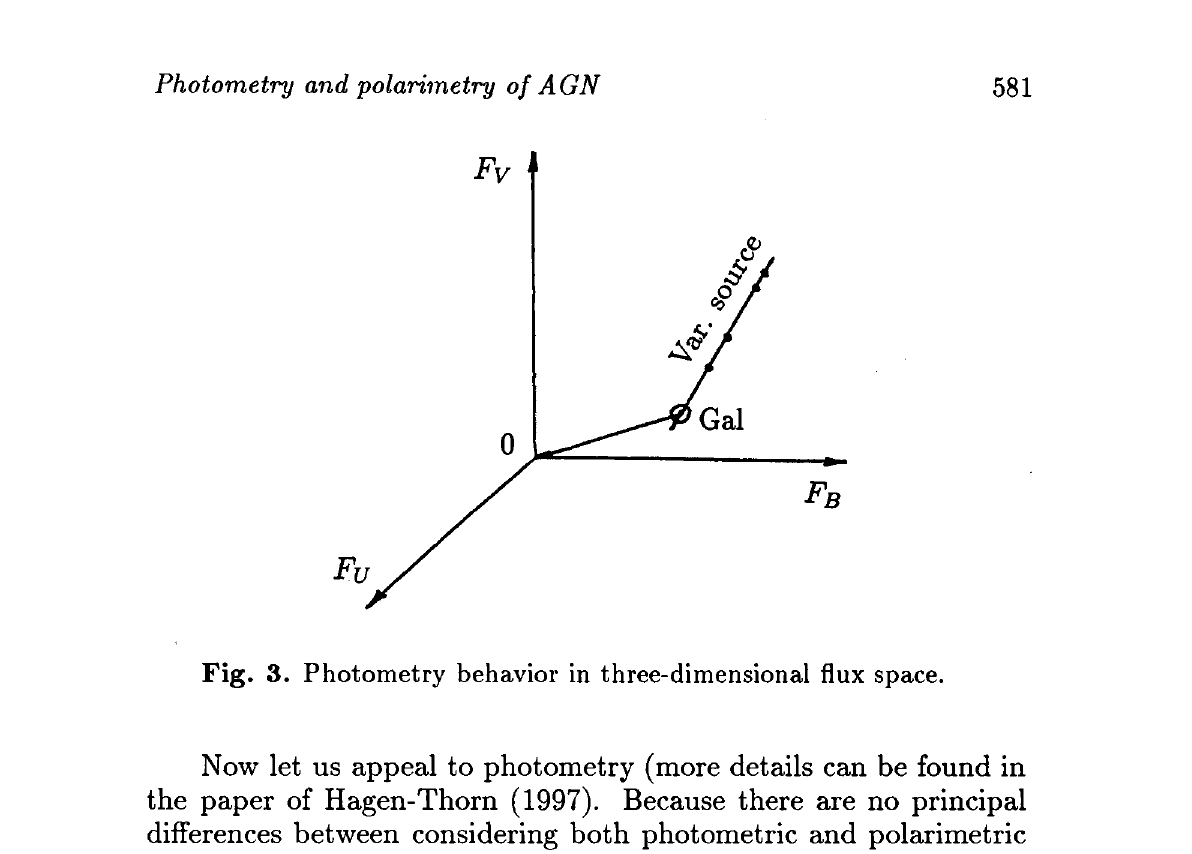
Fig. 3. Photometry behavior in three-dimensional flux